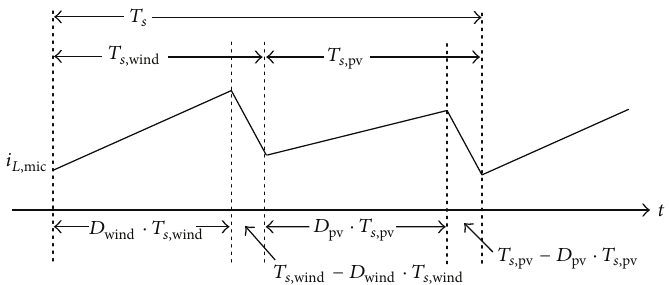
Figure 8: The waveform of output inductor